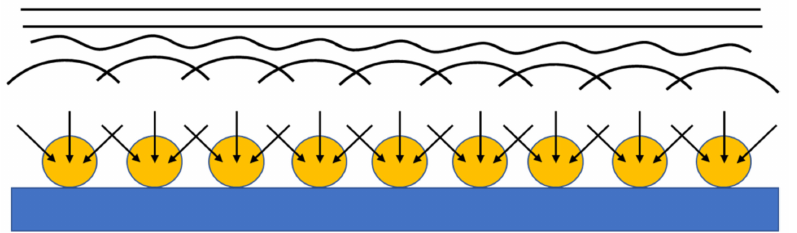
Figure 5. Scheme of modification of convergent diffusion into semi-infinite linear diffusion, when the nanostructure size and interspacing are much smaller than the root mean square of the diffusion length (Equation